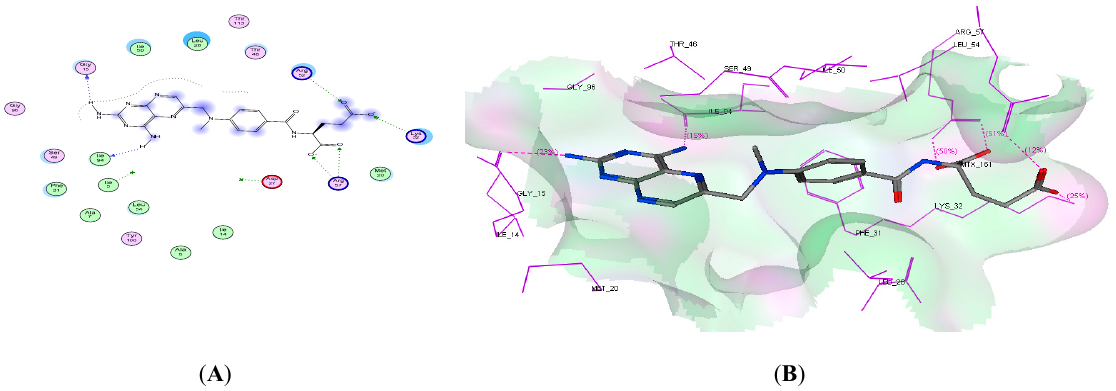
Figure 6. ( A ) 2D interactions of methotrexate with the DHFR binding site. ( B ) 3D interactions of methotrexate with the DHFR binding site.